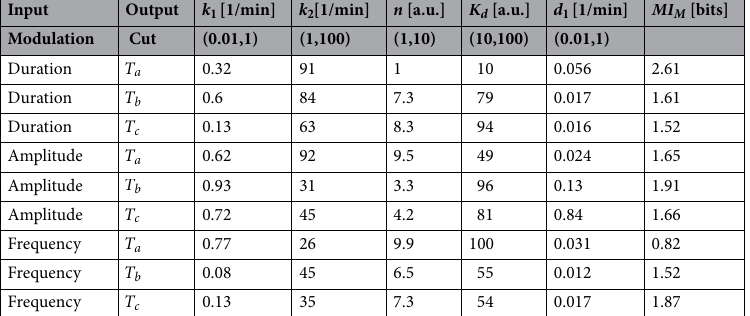
Table 2. Sets of parameters that maximize mutual information, MI , for each combination of input modulation and output integration time and the corresponding value, MI M , obtained in each case. The table shows the range over which each parameter value was varied when looking for this maximum. The parameter, d 2 , was always fixed at d 2 = 0.12 / min. Note that the arbitrary concentration units are such that 100 is the (active) nuclear TF concentration that was used to compute MI in the case of duration or frequency modulation and the maximum such concentration in the case of amplitude